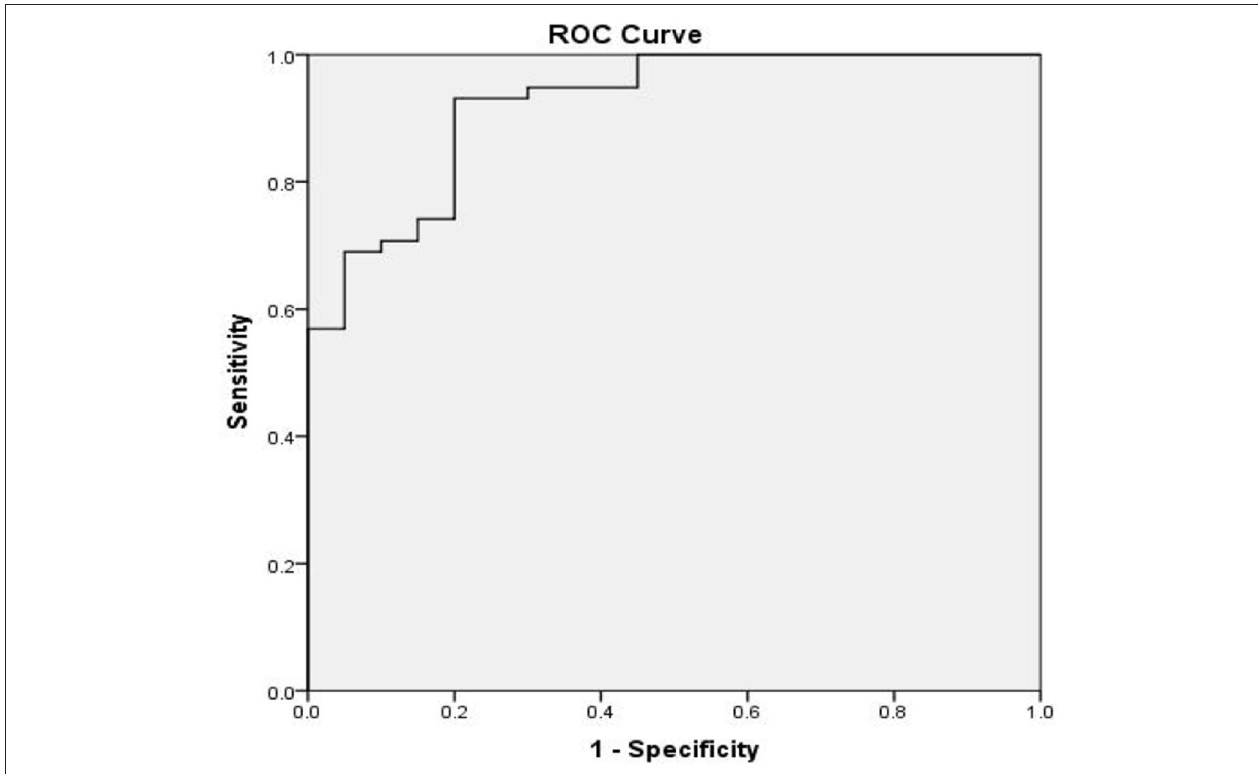
FIGURE 7 | Receiver operator characteristic (ROC) curve based on SERPINA3 levels in patients with alcohol dependence. The area under the curve (AUC) for SERPINA3 was 0.921 ( P < 0.0001), sensitivity was 93.1%, and specificity was 80.0%.